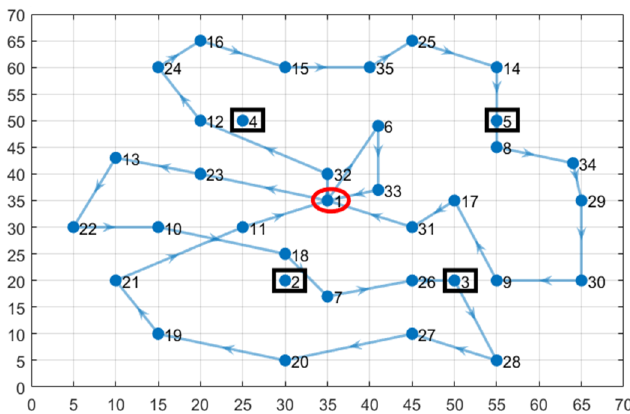
Figure 10. Routes of the best solution (instance 2).